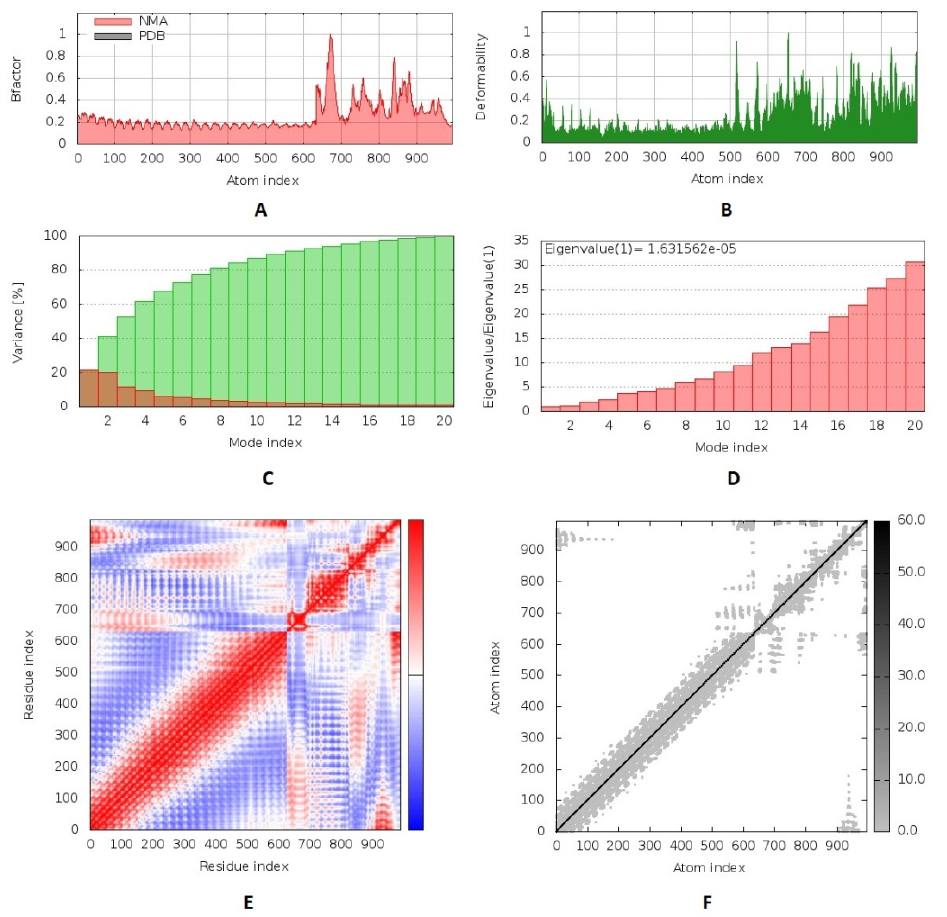
Figure 7. Molecular dynamics simulation of the predicted vaccine–TLR3 complex; complex stability was assessed through B-factor values ( A ), deformability ( B ), variance ( C ), eigenvalue ( D ), the covariance of residue index ( E ), and elastic network analysis ( F ).